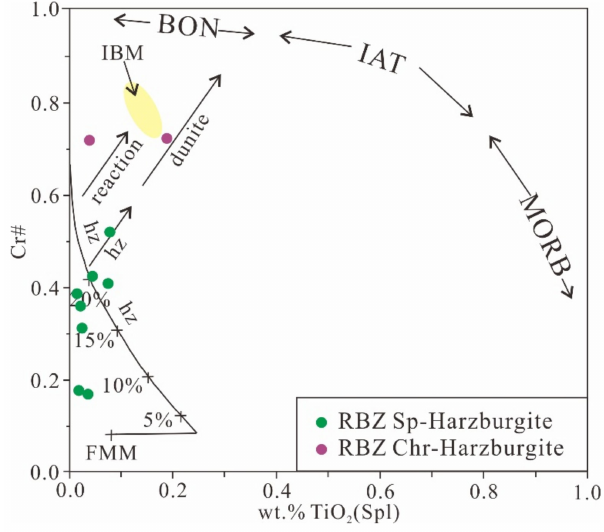
Figure 9. Diagram of TiO 2 and Cr# content from spinel minerals from the Raobazhai complex [39], porosity